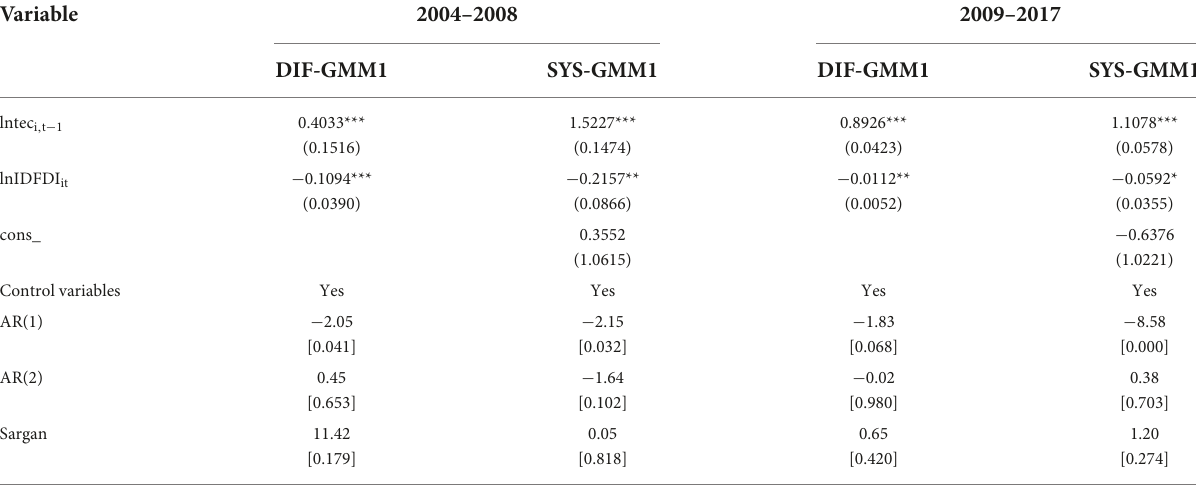
TABLE 9 Environmental technology effects of phased two-way foreign direct investment (FDI) interactive development.